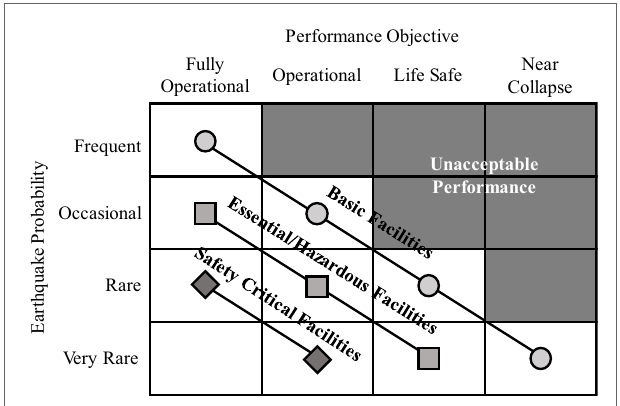
FIGURE 1 | Typical framework for performance-based seismic design (Structural Engineers Association of California, 1995)